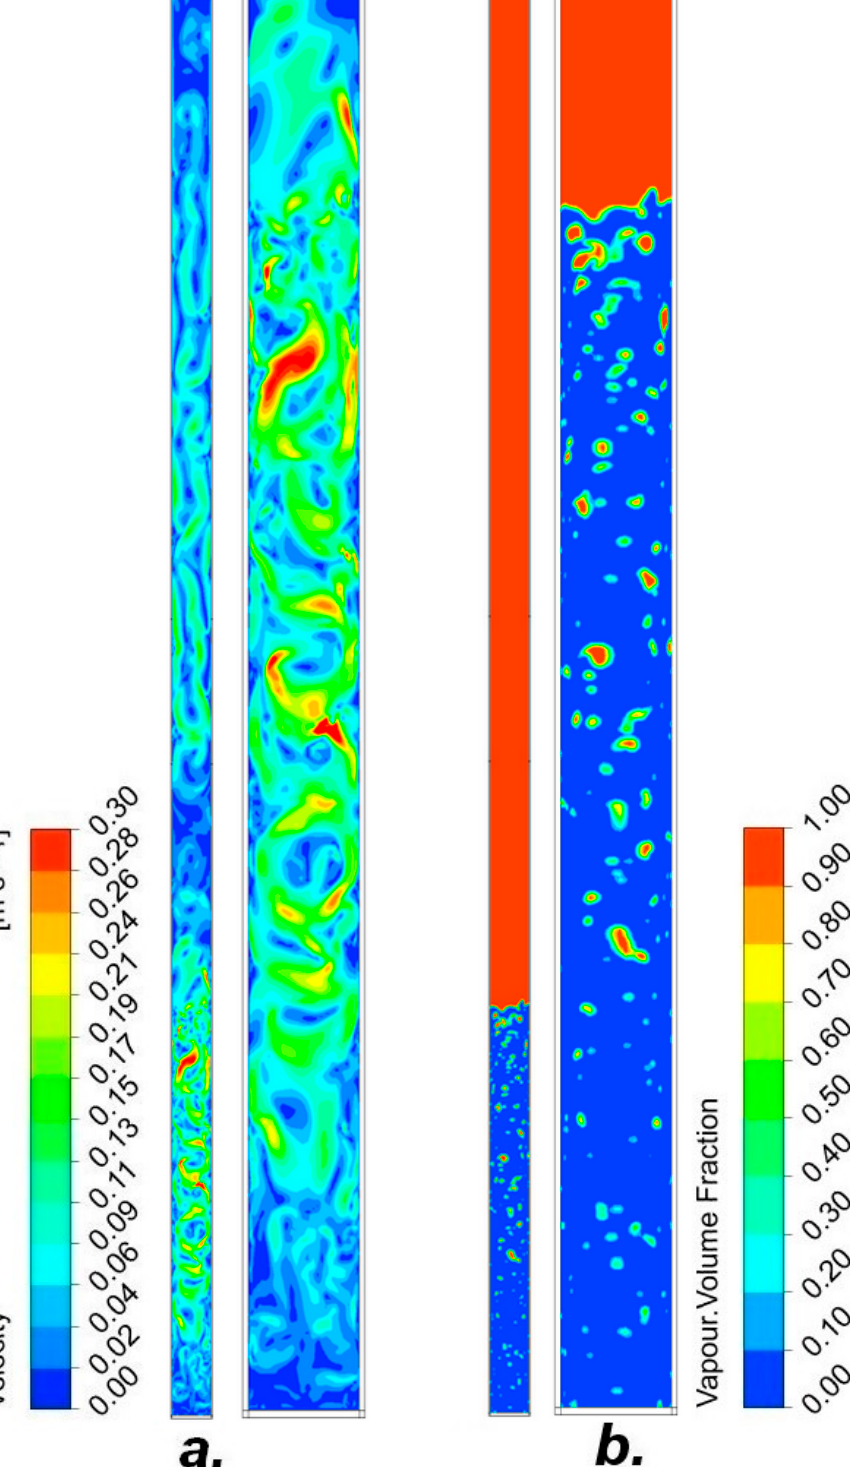
Figure 33. ( a ) Fluid velocity in the total heat pipe and in the condenser section, ( b ) the volume fraction of steam in the total heat pipe and in the evaporator section.